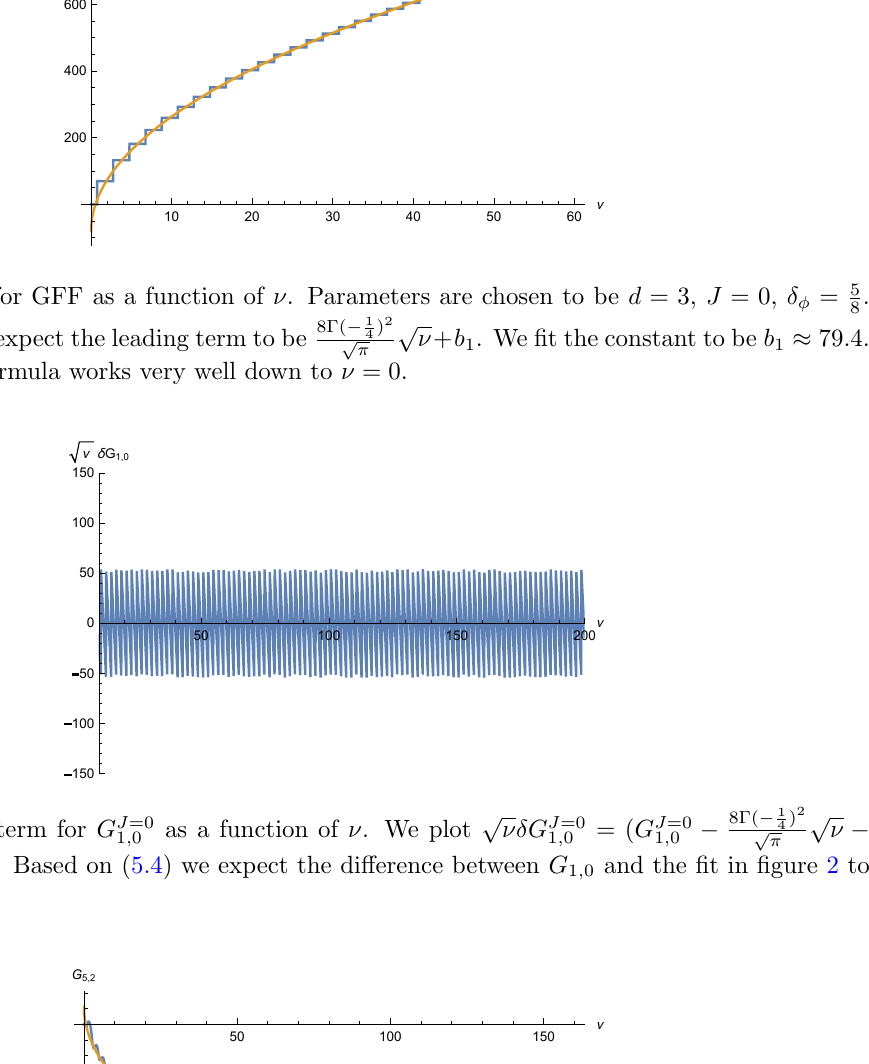
as a function of (cid:23) . We plot 1 ; 0